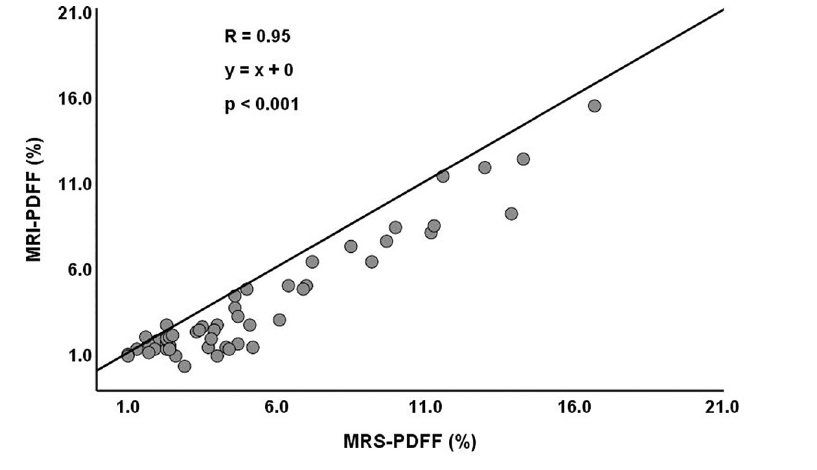
Fig 5. Correlation between MRI-PDFF and